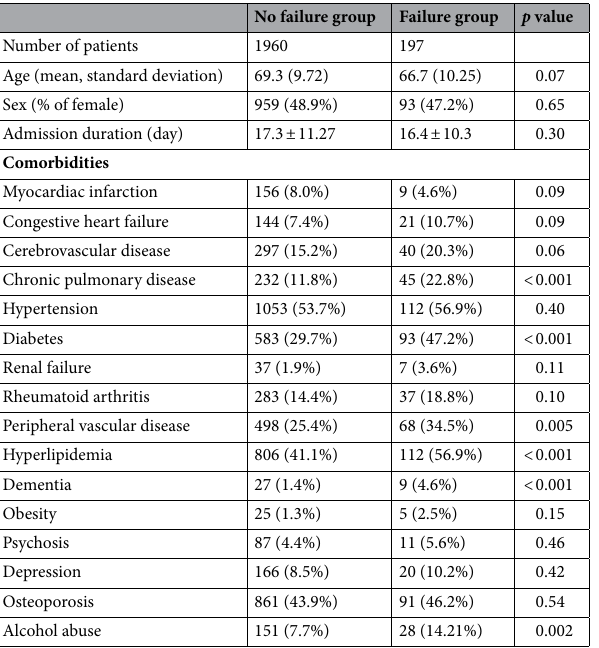
Table 1. Comparison between two groups. *Chi-square test or Fisher’s exact test. Significance at p <